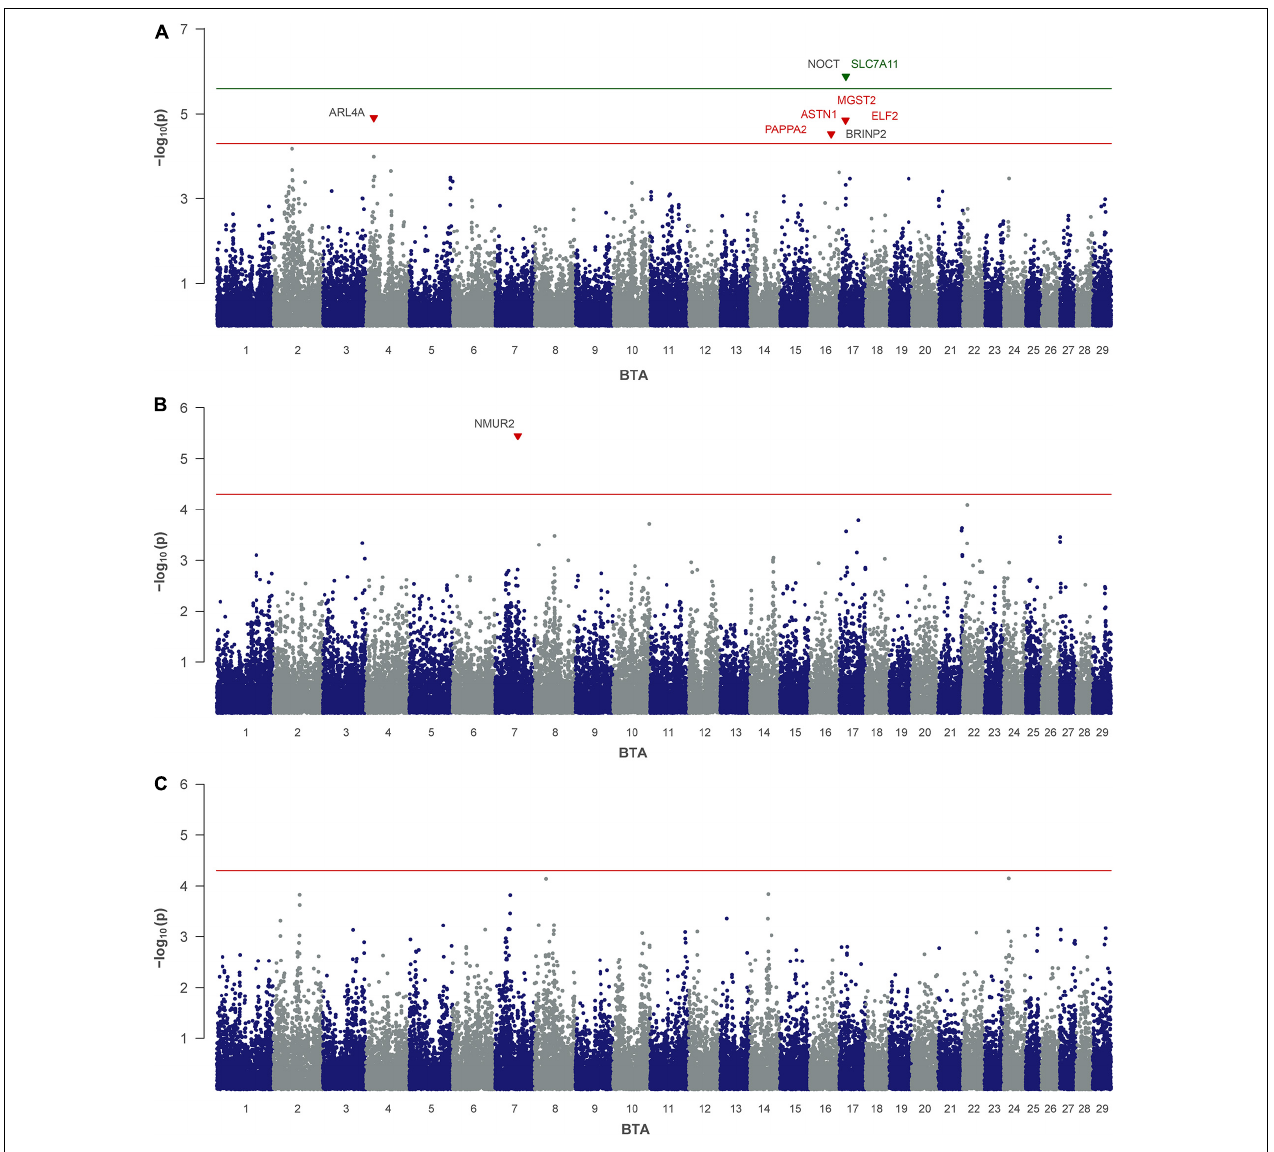
FIGURE 2 | Genome-wide association analysis of non-urea-nitrogen traits: (A) milk nitrogen, (B) uric acid and (C) allantoin. The red and green lines indicate suggestive and genome-wide significance thresholds, respectively. Genes with a suggested positional or biological association to the trait are indicated in red and green. Genes located closest to the right and left of the lead SNP in a 1-Mb window are colored in